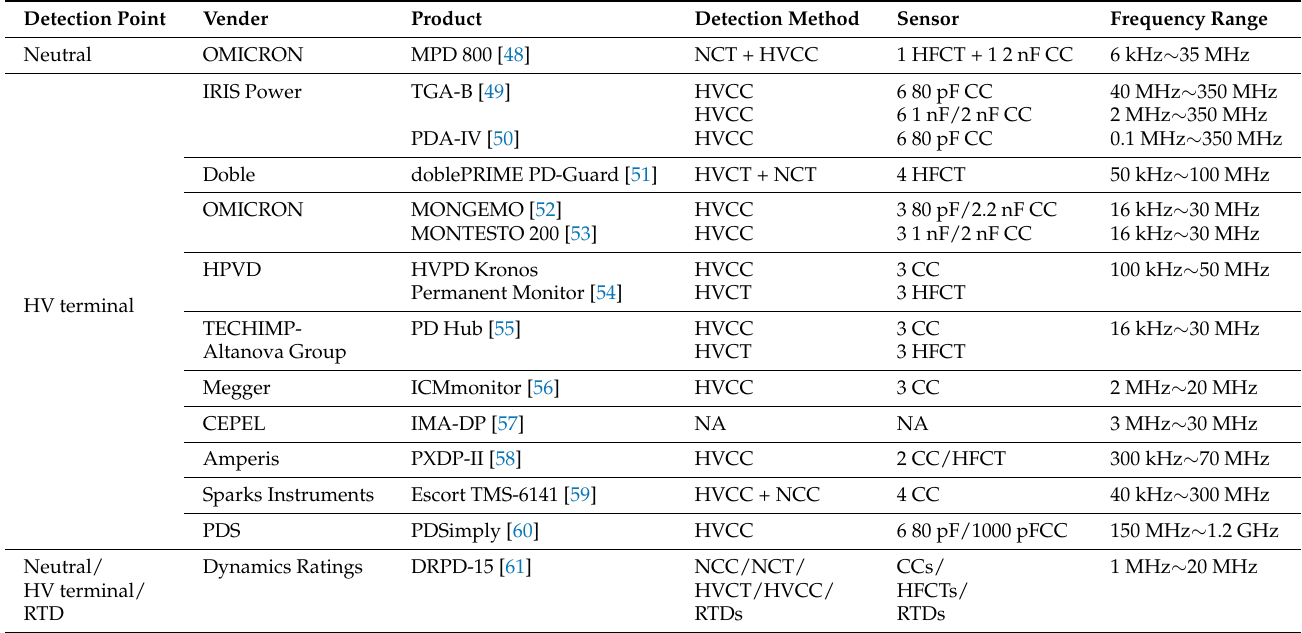
Table 2. Resume of characteristics of some commercial PD online measurement systems for large generators adapted from [13].